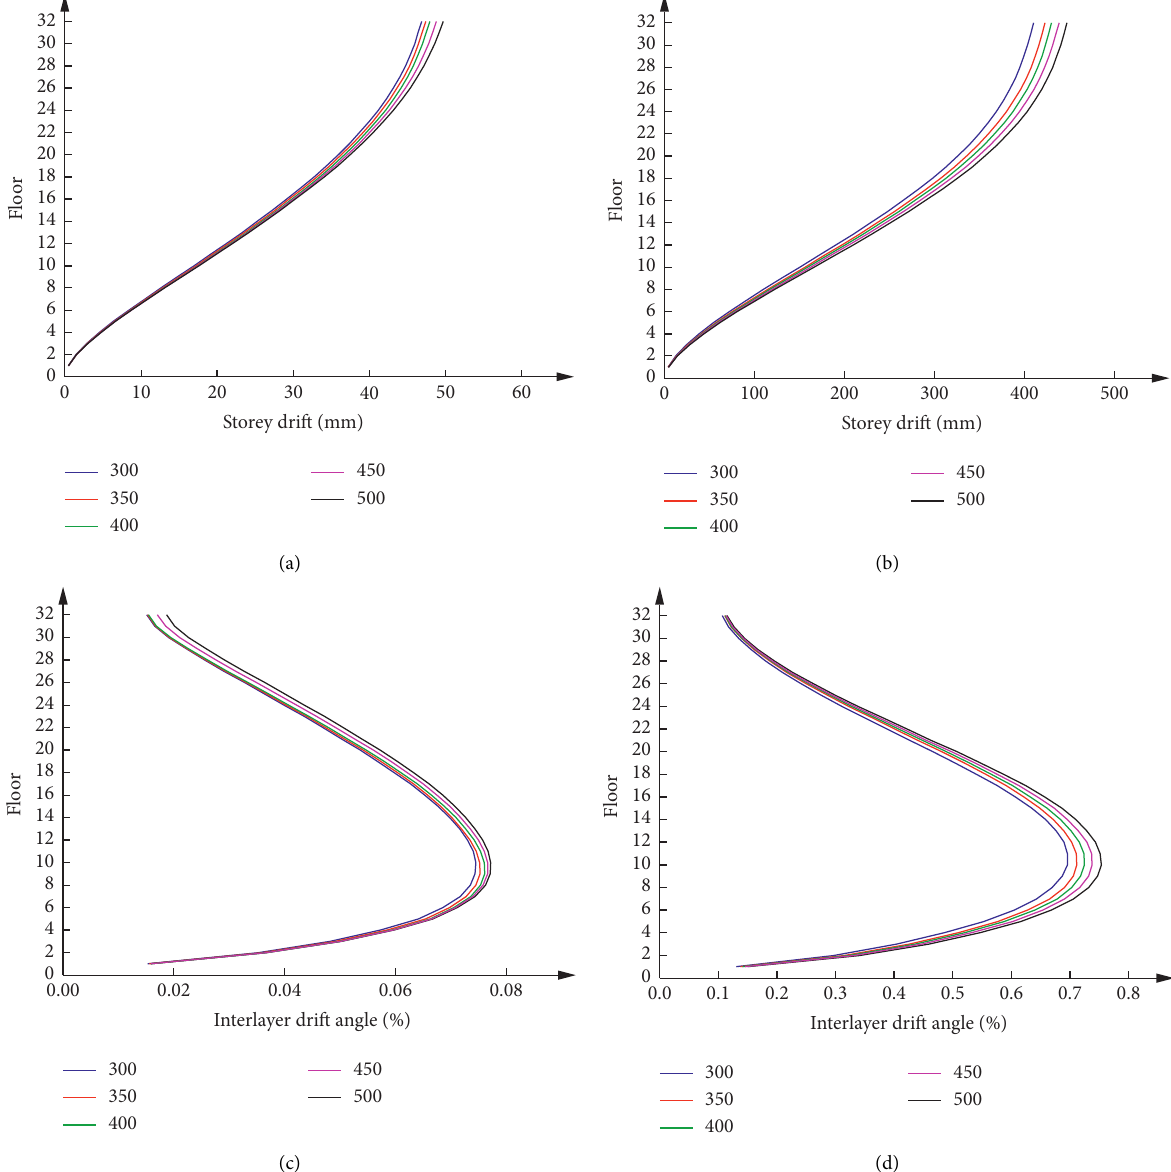
Figure 15: Effect of unbonded length on storey drift (a, b) and interlayer drift angle (c, d) in X direction. (a) Frequent earthquake. (b) Severe earthquake. (c) Frequent earthquake. (d) Severe